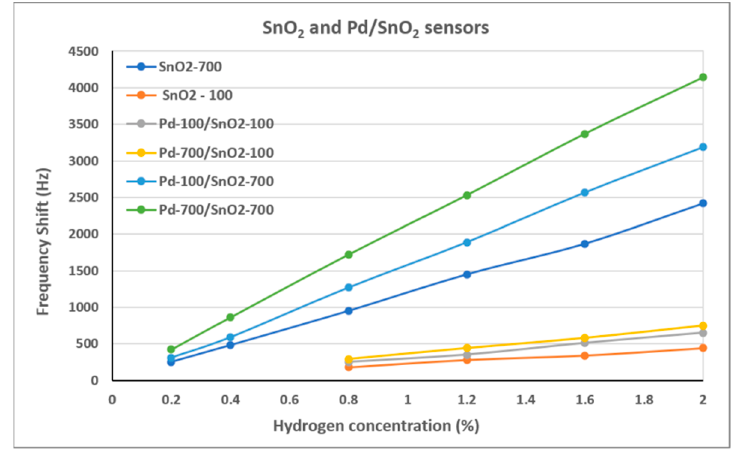
Figure 6. Frequency shift of the SnO 2 and Pd/SnO 2 sensors at different hydrogen concentrations.